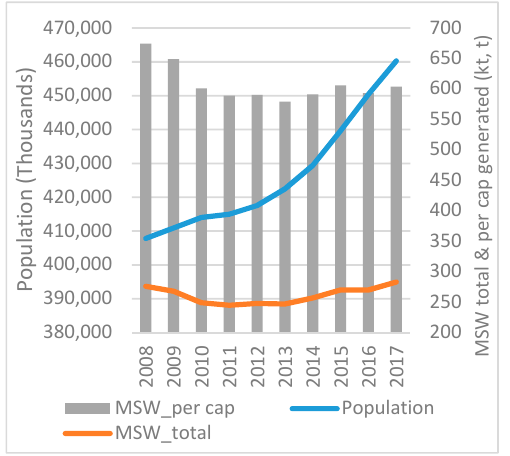
Figure 35. Population and MSW production in Malta 2008–2017 (EUROSTAT 2019a, 2019b).